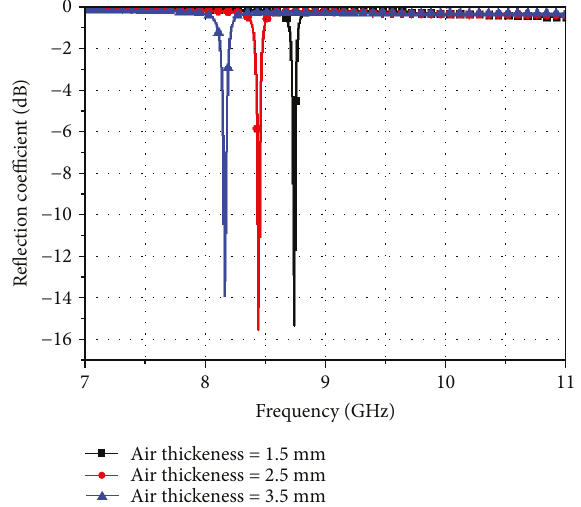
Figure 2: Simulated re fl ection coe ffi cients of the proposed absorber at di ff erent air